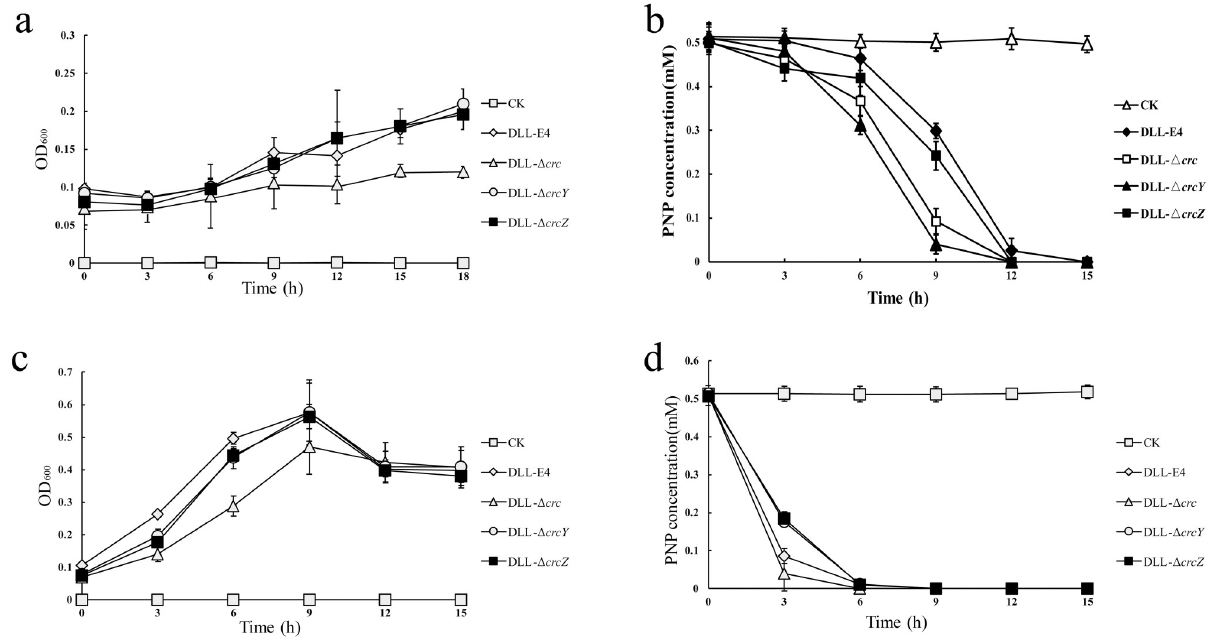
Fig 3. The degradation of PNP by P . putida DLL-E4, DLL- Δ crc , DLL- Δ crc Y, and DLL- Δ crcZ . (a) The growth of P . putida DLL-E4, DLL- Δ crc , DLL- Δ crcY , and DLL- Δ crcZ using PNP as the sole carbon source. (b) PNP degradation by P . putida DLL-E4, DLL- Δ crc , DLL- Δ crcY , and DLL- Δ crcZ using PNP used as the sole carbon source. (c) The growth of P . putida DLL-E4, DLL- Δ crc , DLL- Δ crcY , and DLL- Δ crcZ using PNP and glucose as carbon sources. (d) the degradation of PNP by P . putida DLL-E4, DLL- Δ crc , DLL- Δ crcY , and DLL- Δ crcZ using PNP and glucose as carbon sources. CK: control group, no inoculate any cells, to test whether the culture medium and operation are completely sterile. The values are the means of the results from three biological replicates with standard